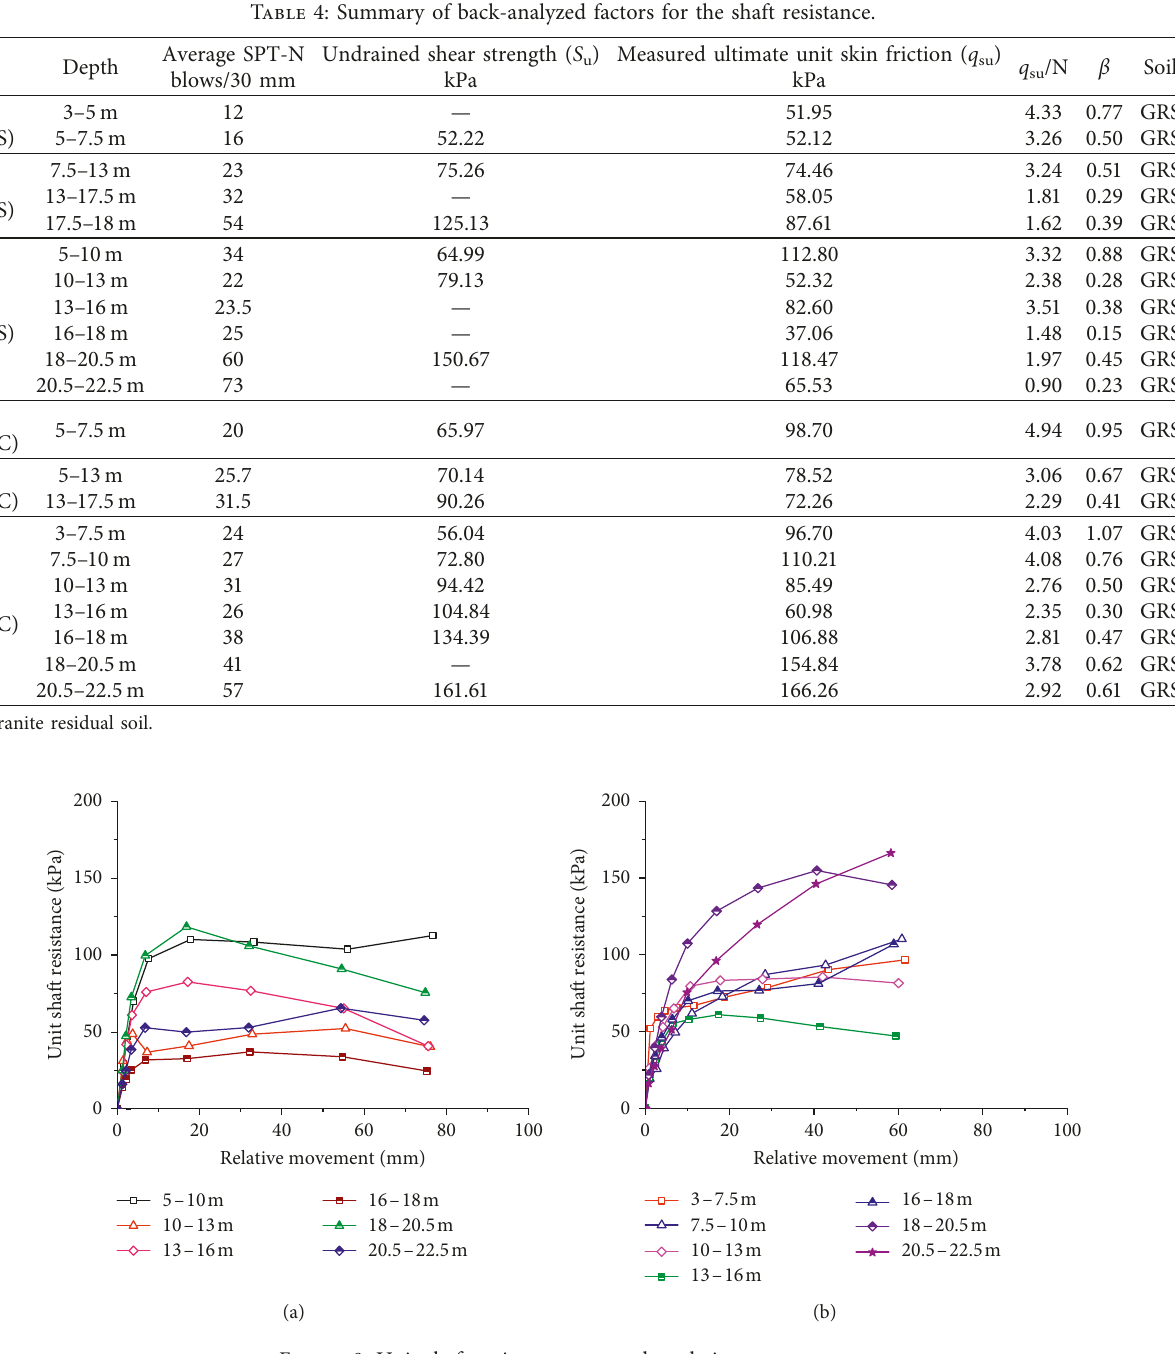
Figure 8: Unit shaft resistance versus the relative